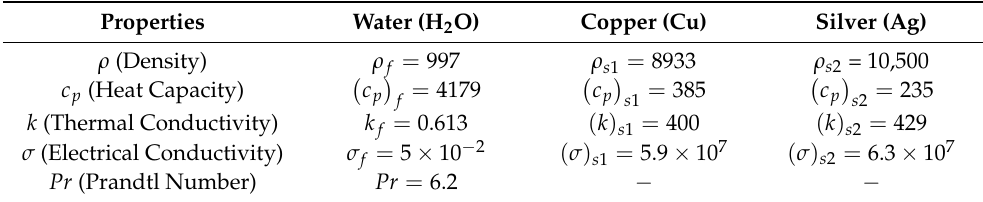
Table 1. Thermo-physical characteristics of base fluid and nanoparticles